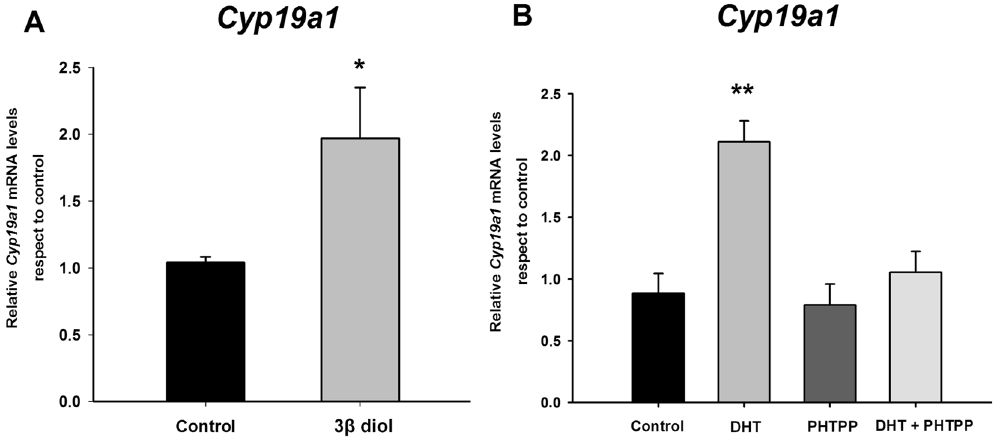
Figure 6. Effect of 5 α -androstane-3 β ,17 β diol (3 β -diol) ( A ) and the selective antagonist of ER β PHTPP ( B ) on aromatase mRNA ( Cyp19a1 ) in female amygdala neuronal cultures from CD1 mouse embryos. 3 β -diol treatment increased Cyp19a1 levels, while PHTPP blocked the effect of DHT on Cyp19a1 levels. * p ≤ 0.05, ** p < 0.01 vs. control. Bars indicate mean + SEM. n = 4–6 independent